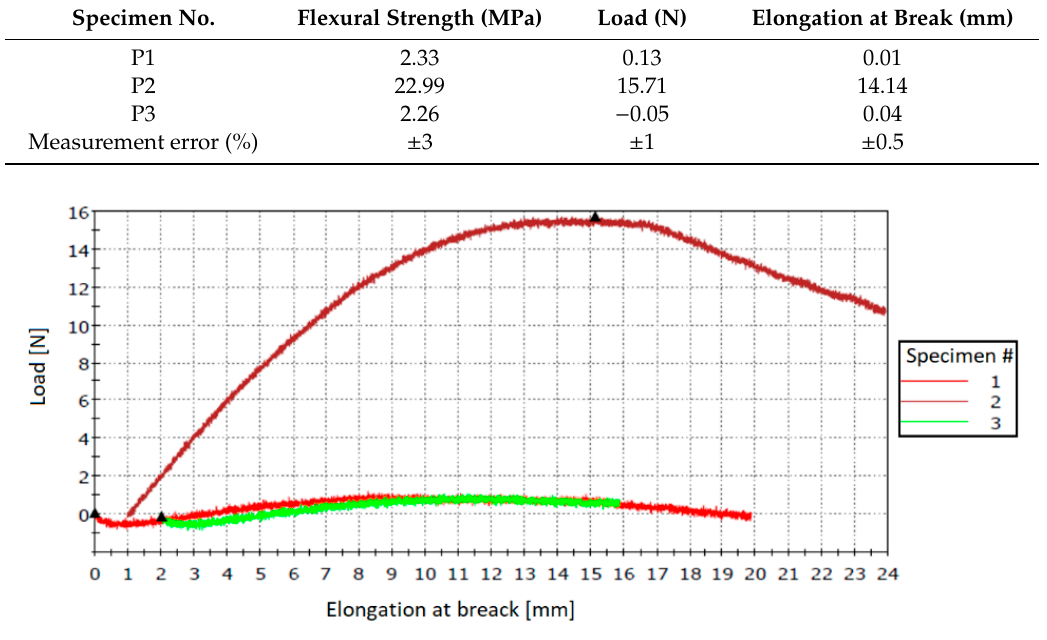
Figure 25. Stress–strain curves for PUF-DCPD specimens fabricated with method 5.